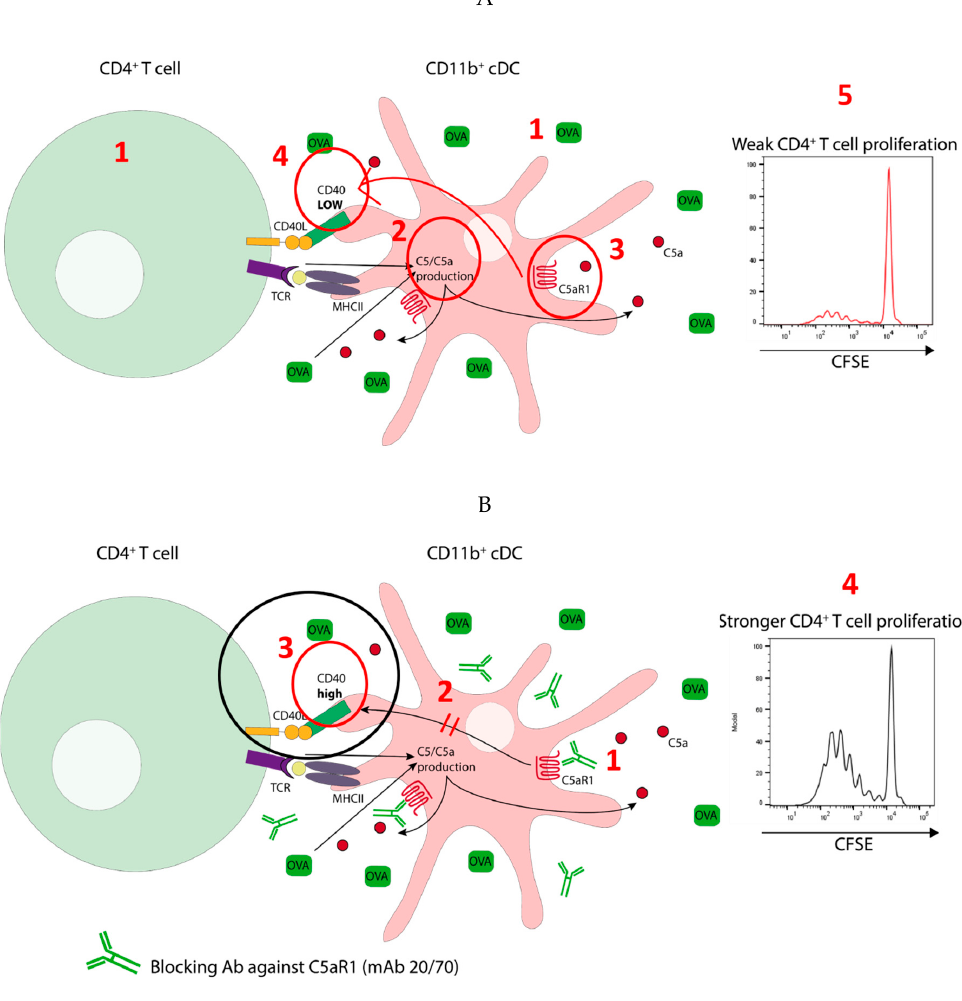
Figure 9. Model detailing the impact of C5a / C5aR1 axis activation in C5aR1 + cDCs on the activation of antigen specific CD4 + T cells. ( A ) Low potency of C5aR1 + cDCs to drive proliferation of antigen specific CD4 + T cells. C5a-mediated activation of C5aR1 suppresses the expression of CD40 in MHC-II lo C5aR1 + cDCs. Under such conditions CD40 is critical for cDC-driven proliferation of antigen-specific T cells. ( B ) C5aR1-targeting of C5aR1 + cDCs increases their potency to drive CD4 + T cell proliferation. The lack of C5aR1 signaling results in increased CD40 expression in MHC-II lo C5aR1 + cDCs leading to improved synapse formation and stronger T cell